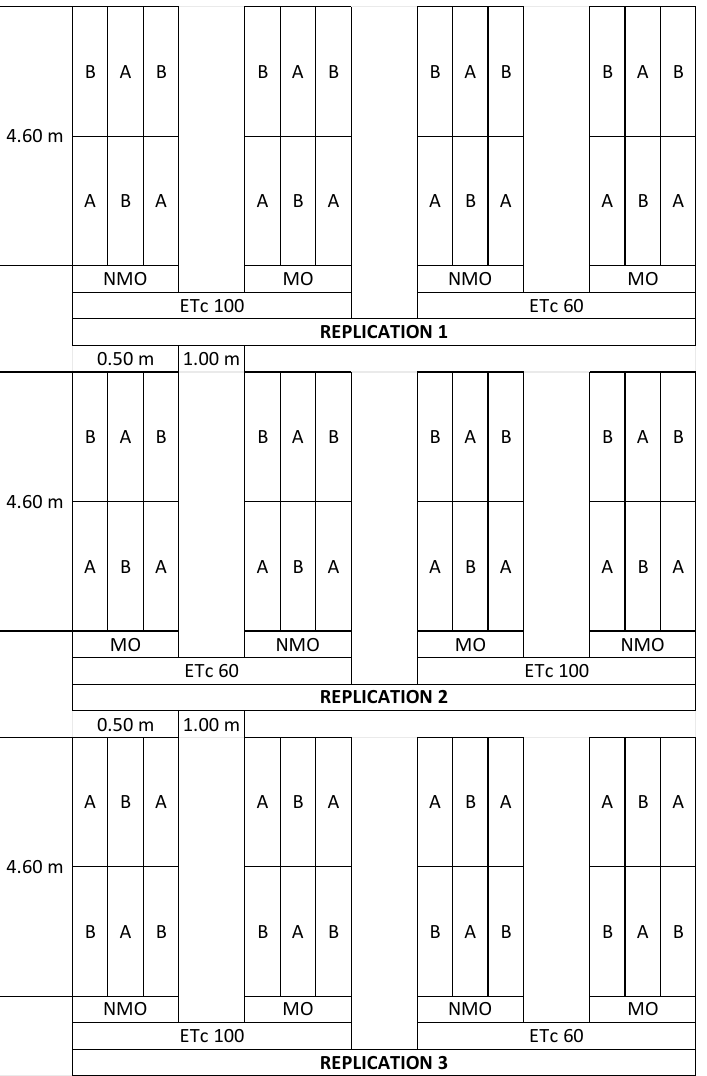
Figure 1. Experimental design. The experimental field was arranged as “split plot” with three experimental factors and three replications. The two different irrigation regimes were based on ETc (ETc 100 and ETc 60). The sub-plot was represented by application or not of PGPMs (MO or NMO); the sub-sub-plot was represented by the two genotypes of snap bean adopted: Domino (A) and Maxi (B).